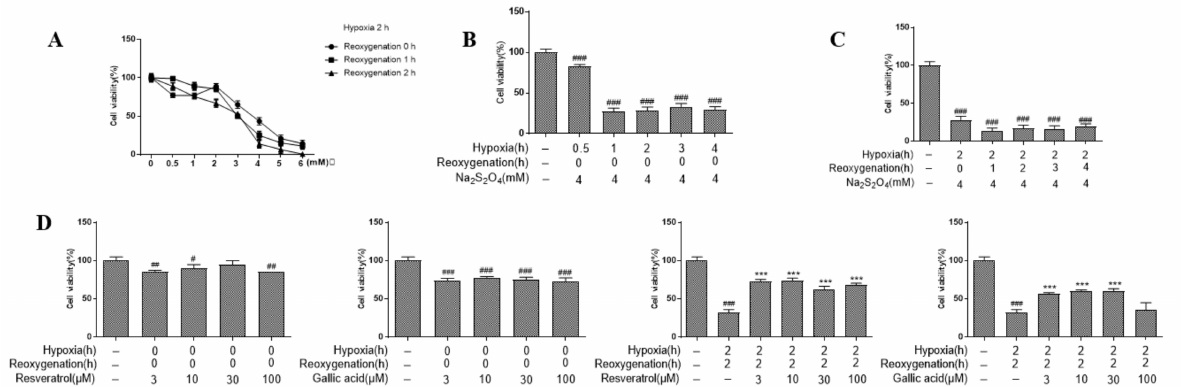
Figure 1. The establishment of mimic hypoxia/reoxygenation model in H9c2 cells; ( A ) Effects of different concentrations of Na 2 S 2 O 4 on the viability of cardiomyocytes. ( B ) Effects of 4 mM Na 2 S 2 O 4 hypoxia treatment on the viability of H9c2 cardiomyocytes at different hypoxia times. ### p < 0.001 vs. blank. ( C ) Effects of 4 mM Na 2 S 2 O 4 treatment on the viability of H9c2 cardiomyocytes at different reoxygenation times. ### p < 0.001 vs. blank. ( D ) Effects of different concentrations of resveratrol/gallic acid on the survival rate of H9c2 cells. First (from left to right): cytotoxicity of resveratrol on H9c2 cells using MTT assay. Second: cytotoxicity of gallic acid to H9c2 cells using MTT assay. Third: resveratrol at different concentrations affected the survival rate of H9c2 cardiomyocytes after hypoxia for 2 h and reoxygenation for 2 h. Fourth: gallic acid at different concentrations affected the survival rate of H9c2 cardiomyocytes after hypoxia for 2 h and reoxygenation for 2 h. # p < 0.05; ## p < 0.01; ### p < 0.001 vs. blank. *** p < 0.001 vs. model.